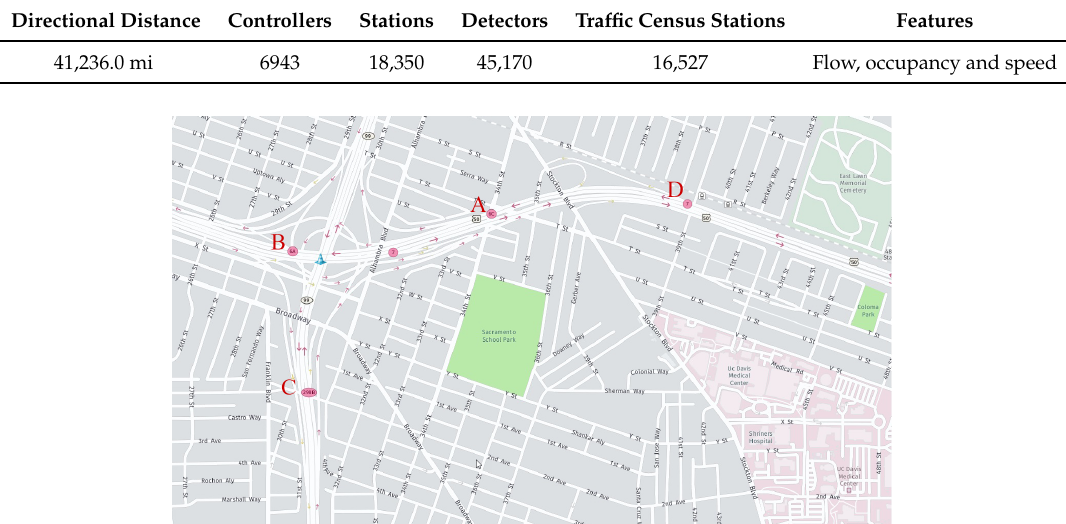
Table 1. The acquisition details of dataset.